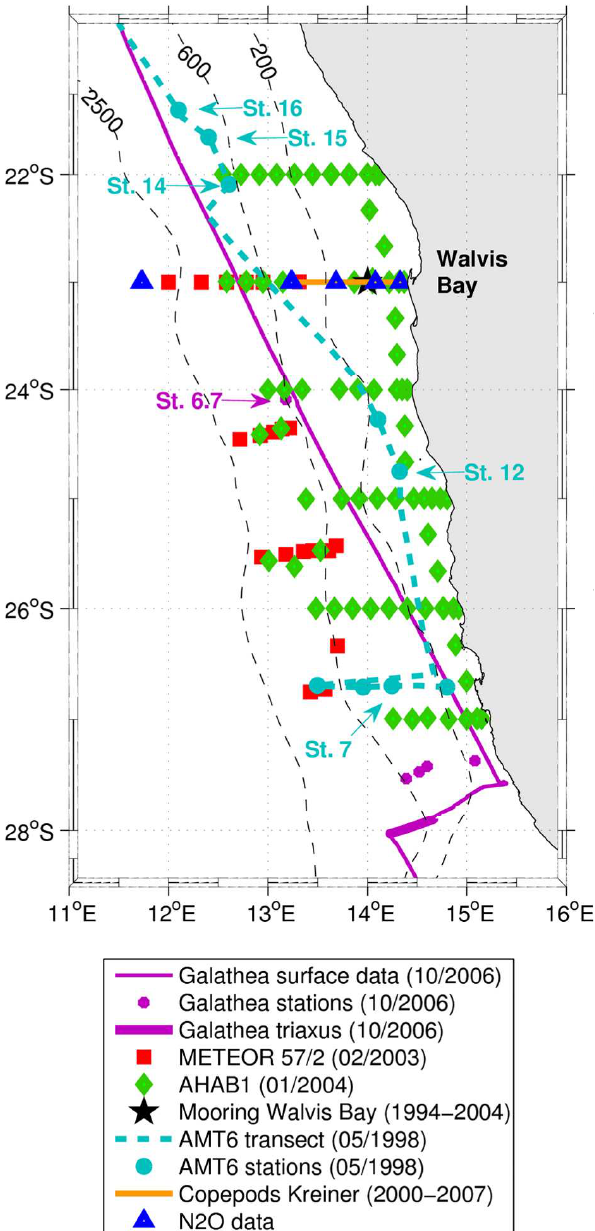
Fig. 3. Cruise sections and stations used for the model/data com- parison: the Danish Galathea expedition (October 2006), the ME- TEOR expedition 57/2 (February 2003), the AHAB1 expedition (January 2004), AMT 6 cruise (May 1998), the Walvis Bay mooring at 23 ◦ S between 1994 and 2004 (Monteiro and van der Plas, 2006), the time series of copepod abundance from the coast (14.5 ◦ E) to 70 nautical miles (13.23 ◦ E) off Walvis Bay at 23 ◦ S between 2000 to 2007 (Kreiner and Ayon, 2008), and the N 2 O data from FRS Africana cruise (December 2009). The black dashed lines indicate the bathymetry (in meters). Specific stations are indicated and will be discussed later in the